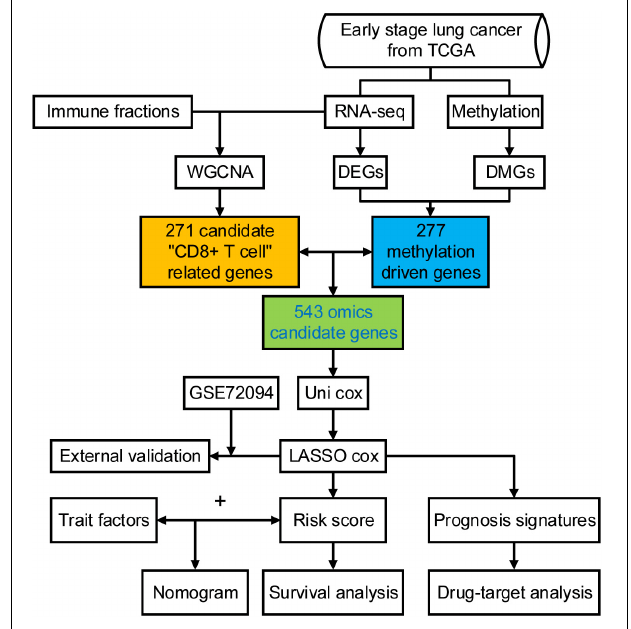
FIGURE 1 | The workflow of the